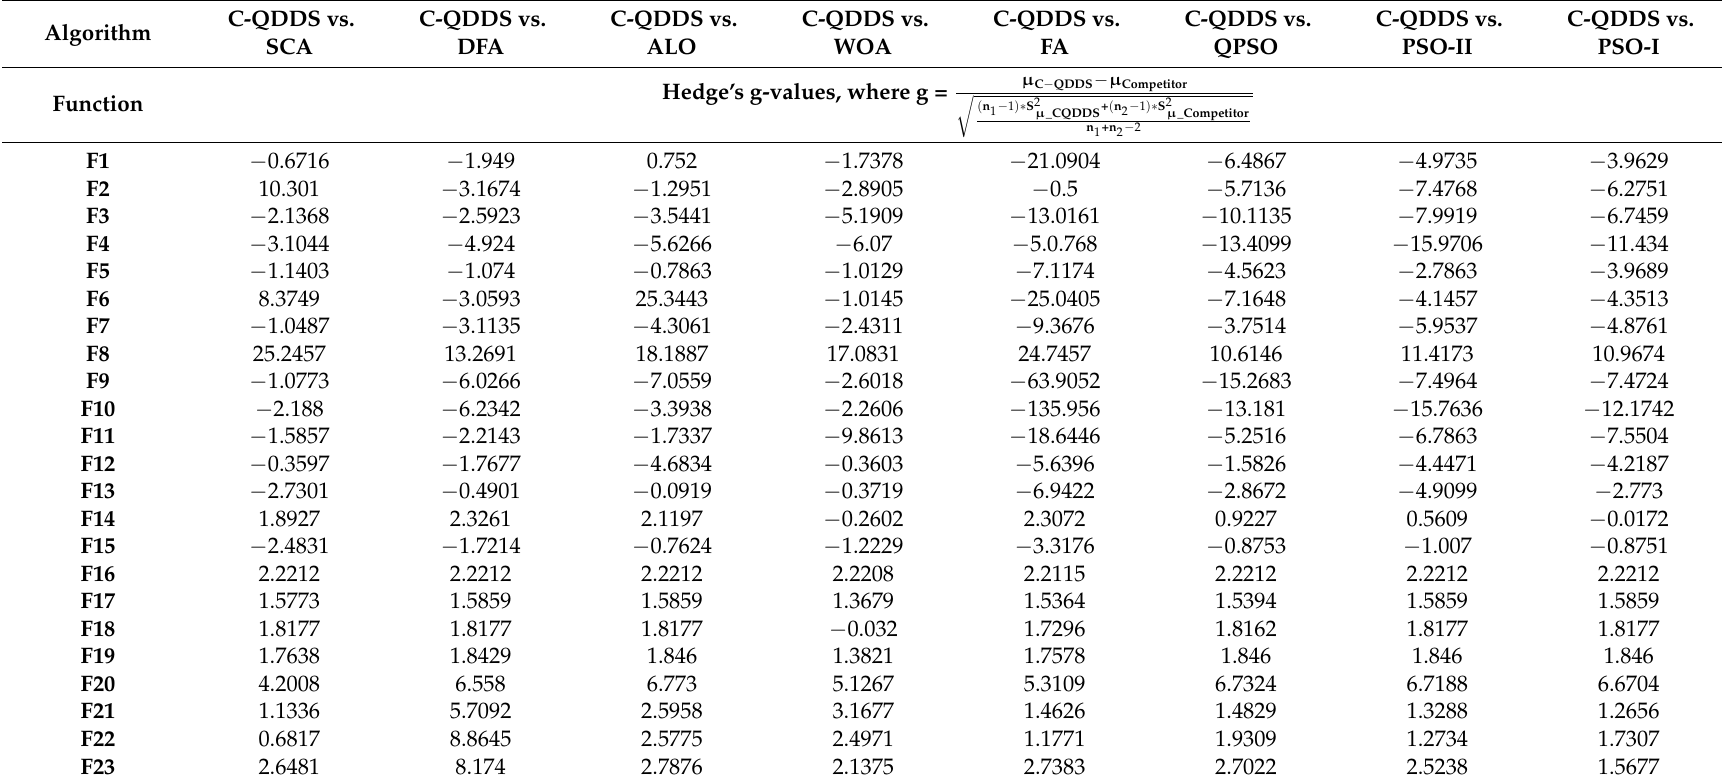
Table 17. Hedges’ g-values for C-QDDS vs.